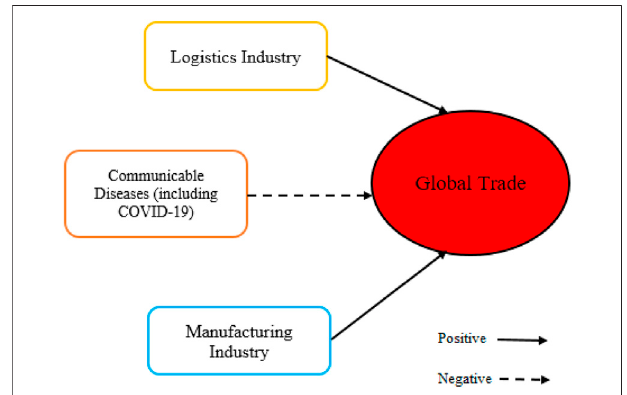
FIGURE 2 | Conceptual